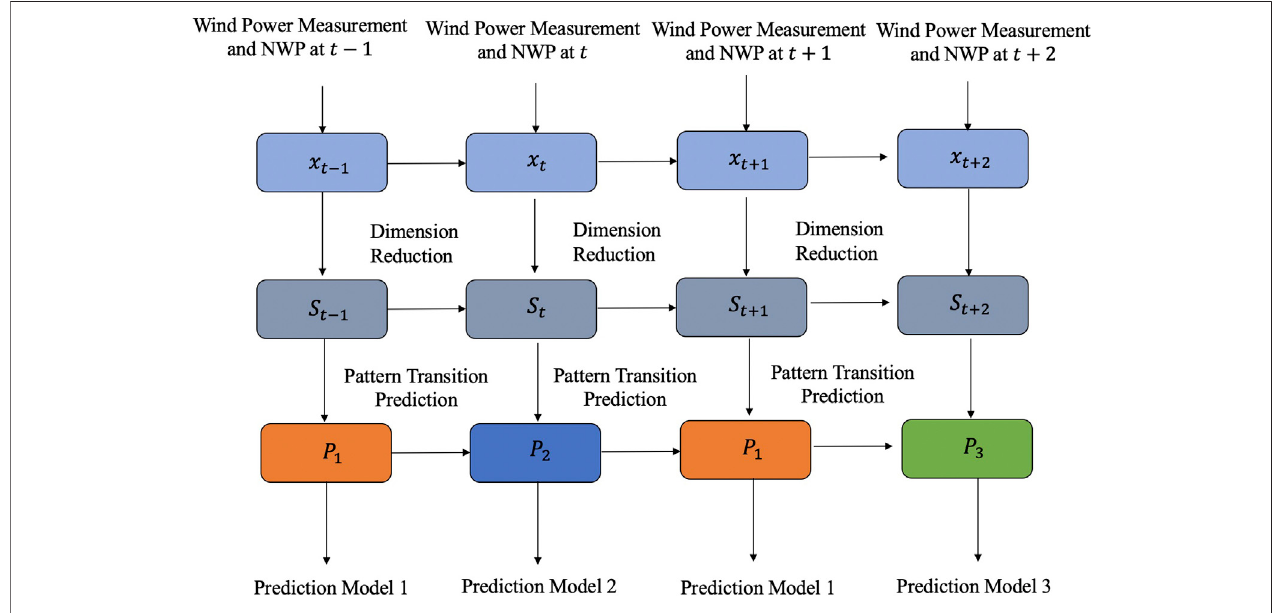
FIGURE 4 | The regime transition of wind power prediction.